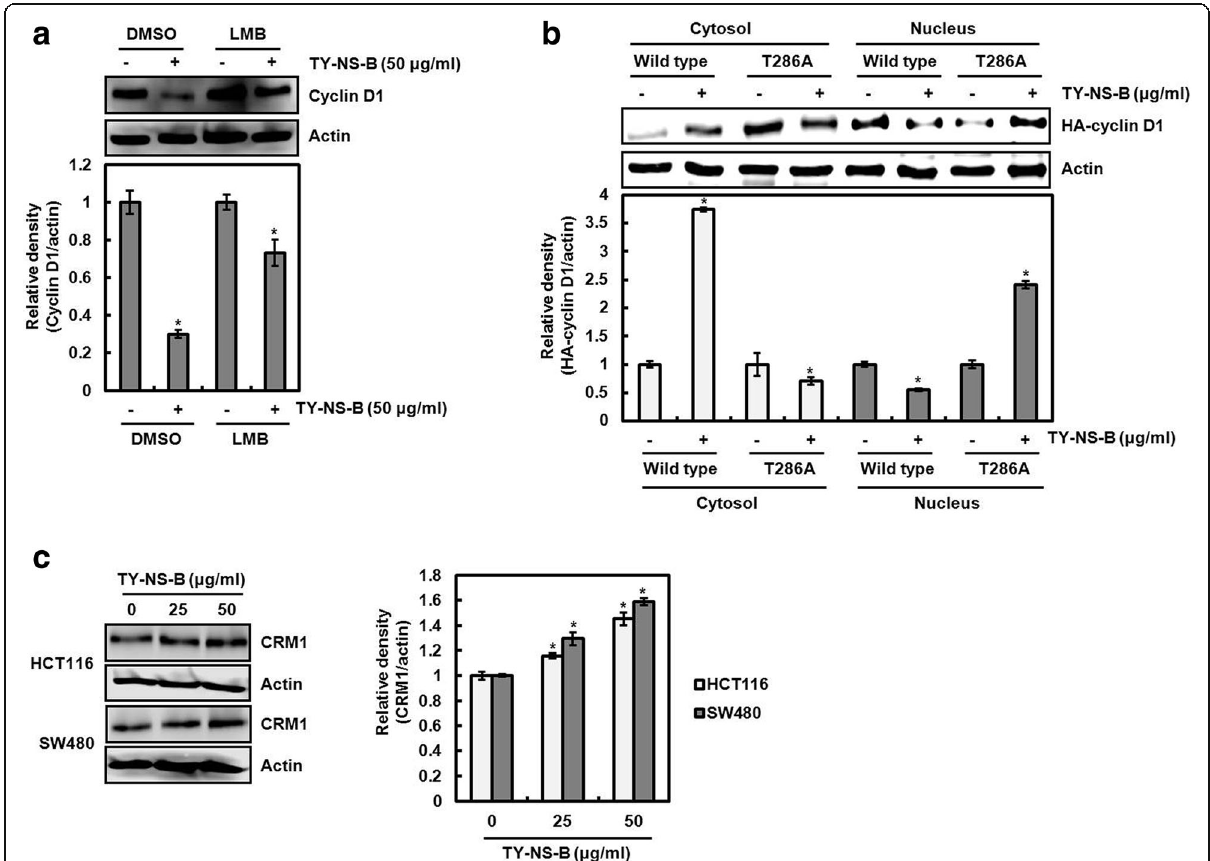
Fig. 8 Cyclin D1 nuclear export contributes to cyclin D1 degradation by TY-NS-B. a HCT116 cells were pretreated with 50 nM of LMB and then co-treated with TY-NS-B (50 μ g/ml). b HCT116 cells were transfected with HA-tagged wild type-cyclin D1 or T286A-cyclin D1, and then co-treated with TY-NS-B (50 μ g/ml). After treatment, cytoplasm and nucleus were prepared. c HCT116 and SW480 cells were treated with TY-NS-B. Cell lysates were subjected to SDS-PAGE and the Western blot was performed using antibody against cyclin D1, HA-cyclin D1 and CRM1. Actin was used as internal control for Western blot analysis. Relative density for Western blot was measured using the software Un-SCAN-IT gel Version 5.1 (Silk Scientific, Inc). Data represent mean ± SD for three independent experiments. * P < 0.05 compared to cell without